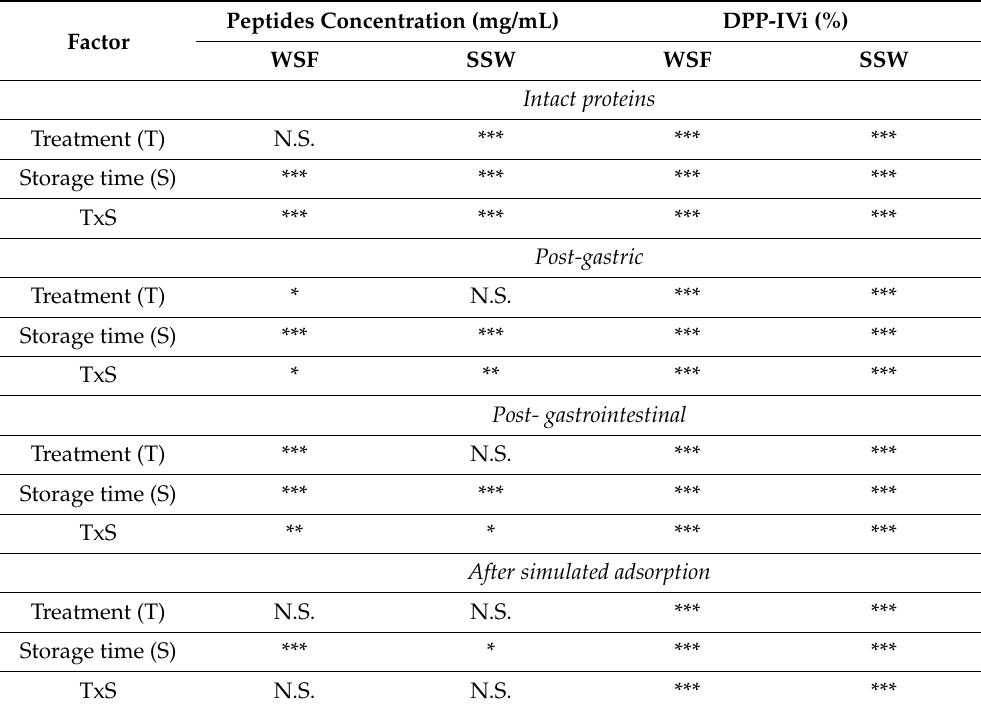
Table 1. Significance levels shown by the experimental factors and their interactions for the DPP-IVi of dry-cured loins during long-term aging and in vitro gastrointestinal